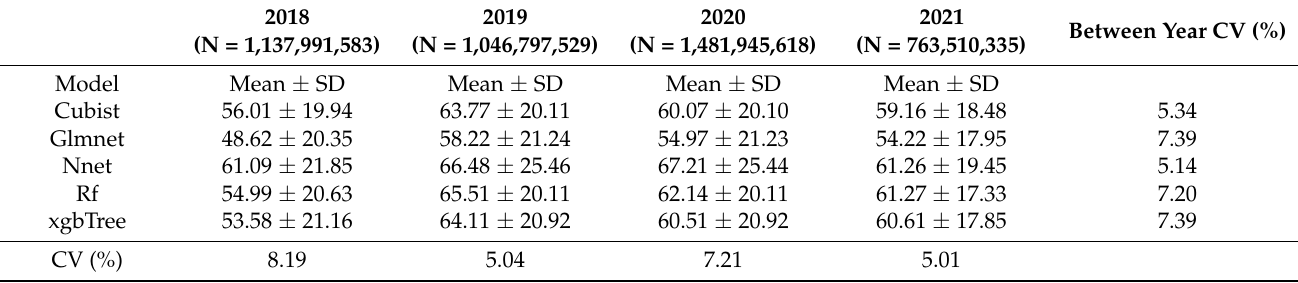
Table 6. Descriptive statistics of the cleaned dataset using the five studied models predicting the compressed sward height (mm). CV = coefficient of variation, the ratio of the standard deviation (SD) by the mean multiplied by 100, N stands for the number of